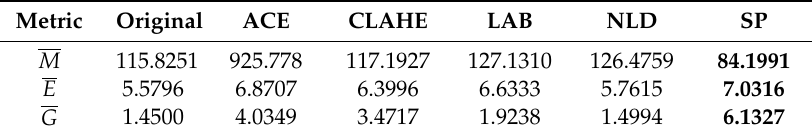
Table 3. Average metrics for the sample image “CalaMinnola2” enhanced with all algorithms. Metric Original ACE CLAHE LAB NLD SP M 115.8251 925.778 117.1927 127.1310 126.4759 84.1991 E 5.5796 6.8707 6.3996